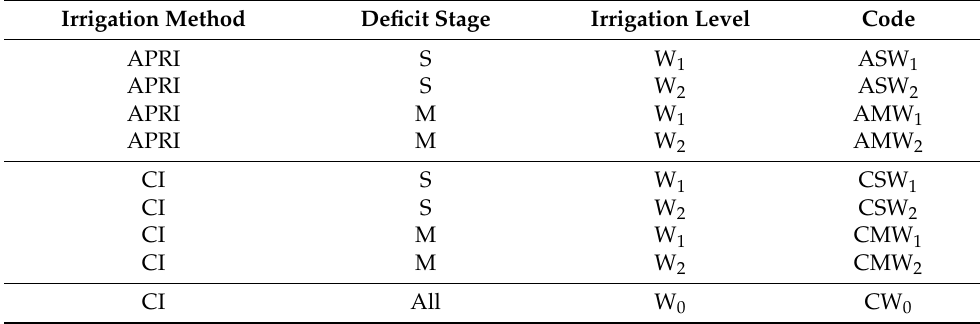
Table 2. Treatments of the experimental design.